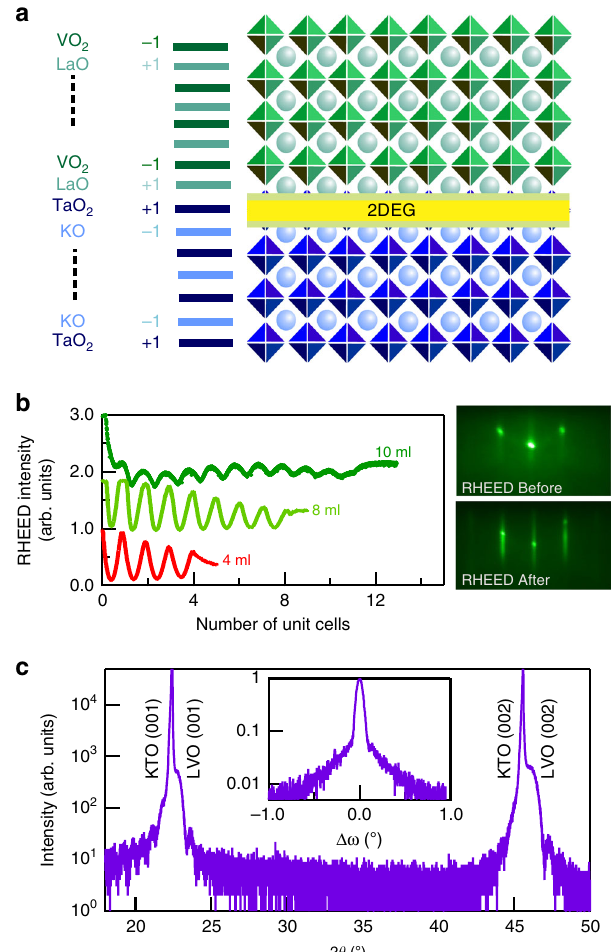
Fig. 1 LVO-KTO interface structural characterization. (Color online) a Schematic of the LVO-KTO heterostructure showing alternately charged layers in both LVO and KTO leading to formation of 2DEG at the interface ( b ) RHEED oscillations for 4, 8, and 10 ml LVO-KTO samples and RHEED pattern for 10 ml sample before and after growth of LVO fi lm. c X-ray diffraction pattern of 40 ml sample showing crystalline fi lm growth of LVO on